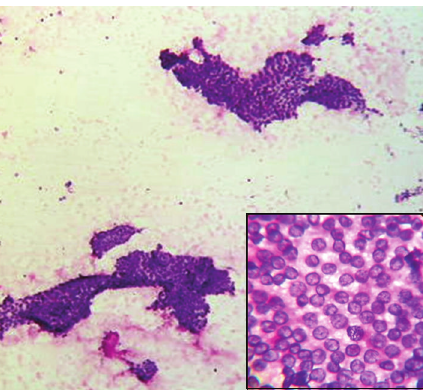
Figure 1: FNAC from thigh swelling shows monolayered sheets and papillary structures of follicular cells. Background shows thick colloid. Inset show intranuclear grooves and nuclear cytoplasmic vacuoles.